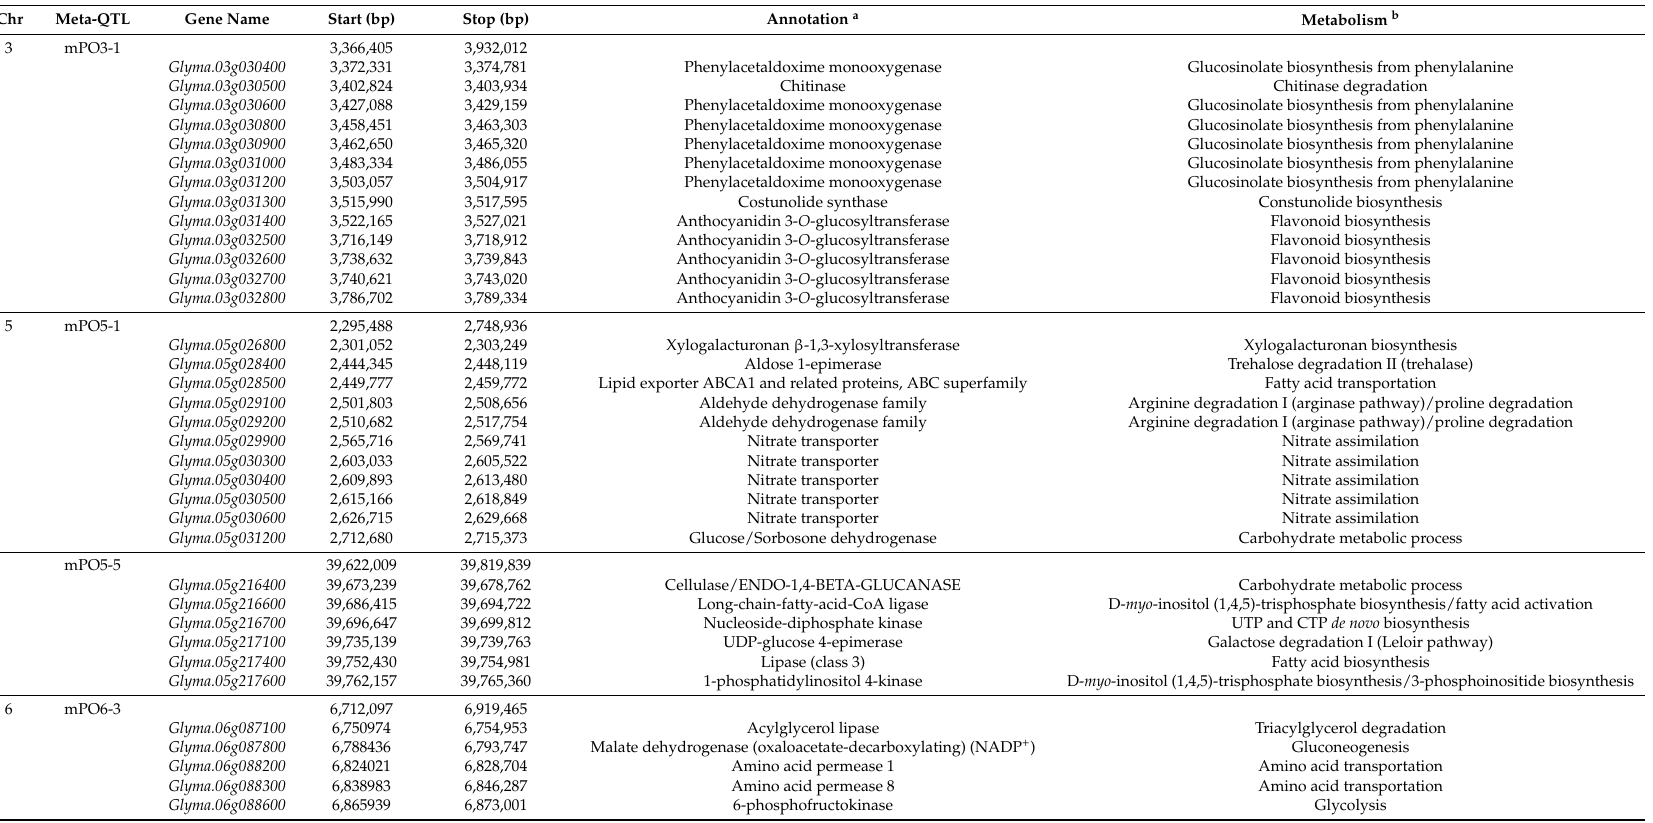
Table 2. List of selected positional and functional candidate genes by